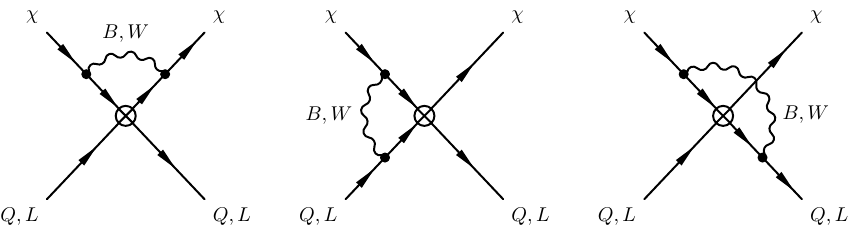
; : : : ; Q (6) operators due to the exchange 1 ;i 14 ;i